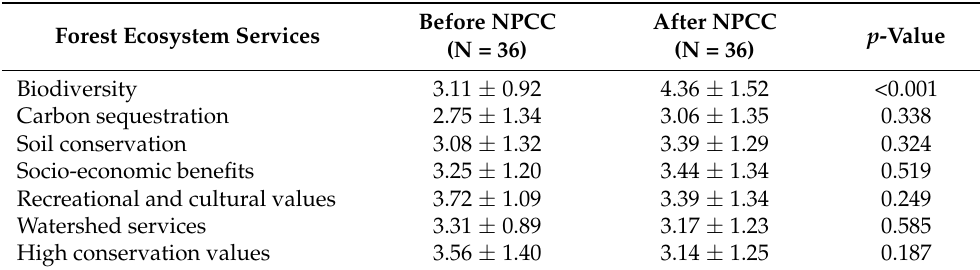
Table A1. Effectiveness scores of the implemented adaptation actions by forest ecosystem services before and after NPCC.